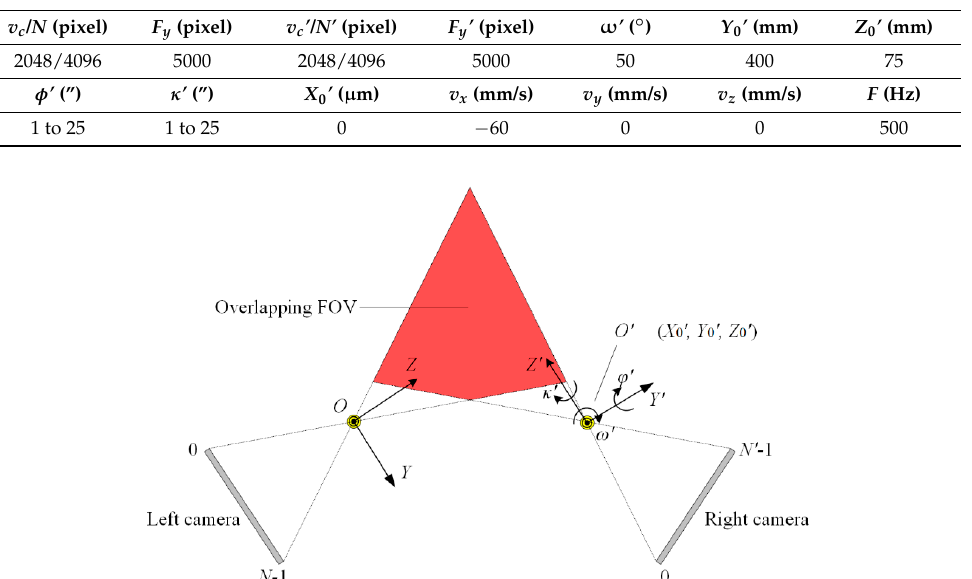
Figure 6. Epipolar curve for a given left pixel value. Table 1. Parameters used for simulation of the lateral error.